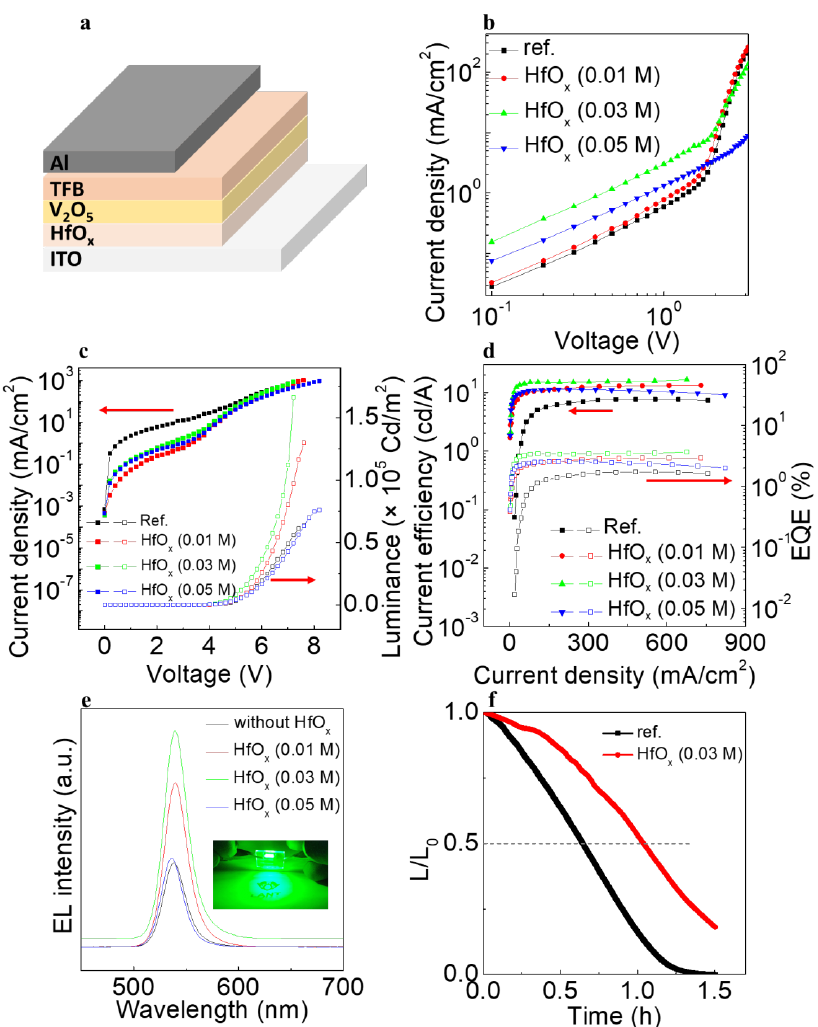
Figure 6. ( a ) Schematic illustration of the device fabrication process ( b ) J − V characteristics of HOD devices. ( c ) J − V − L characteristics and ( d ) current efficiency − current density plot of the QLED devices. ( e ) EL spectra of the QLED devices at each maximum luminance. ( f ) Lifetime data of the QLED devices without and with HfO x (0.03 M) layer.